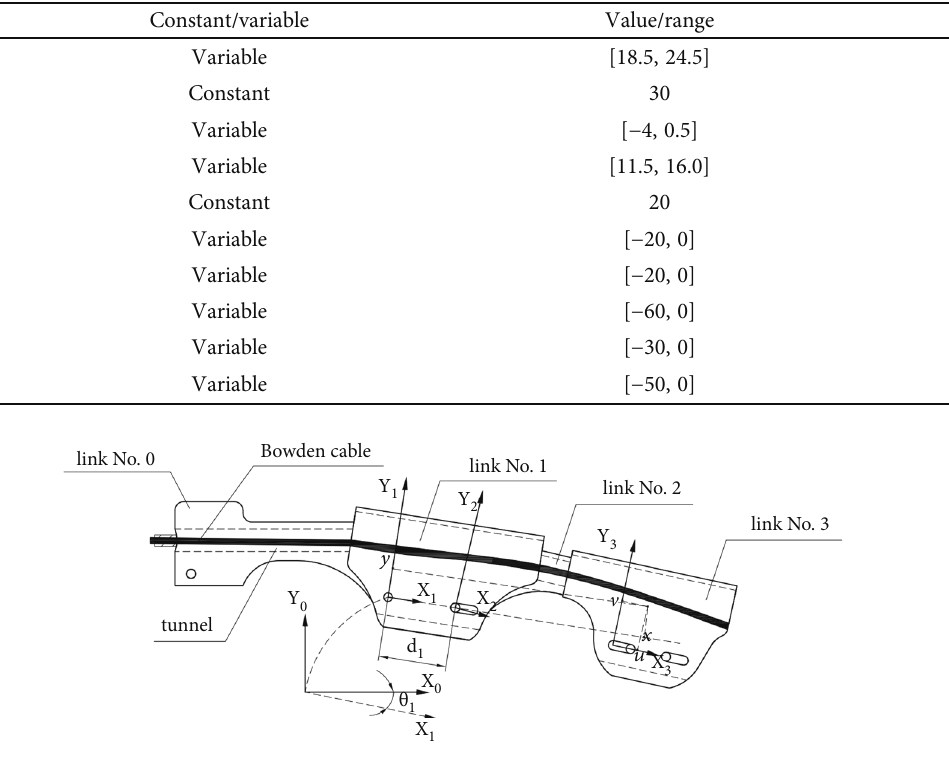
Figure 5: De fi nition of some kinematics variables.